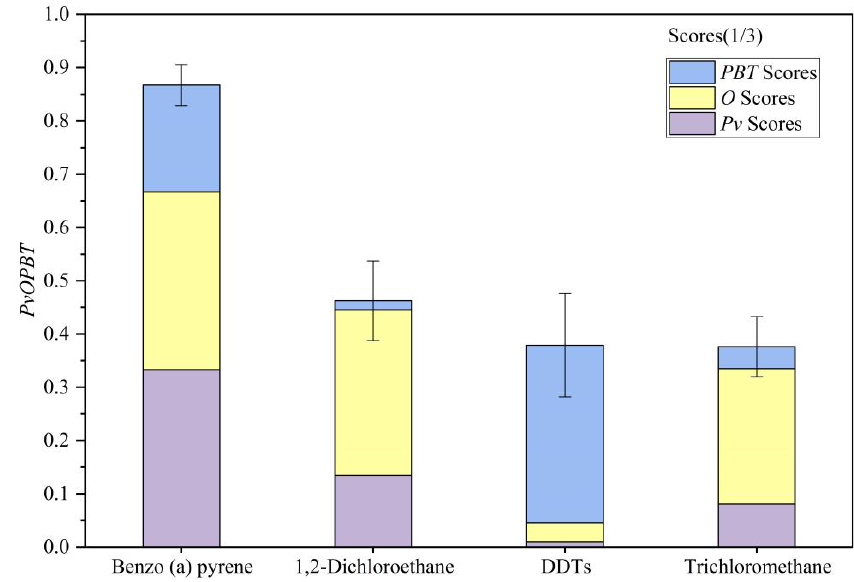
Figure 5. PvOPBT scores for PCOPs in groundwater.